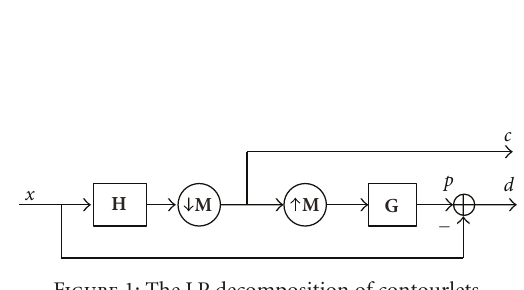
Figure 1: The LP decomposition of